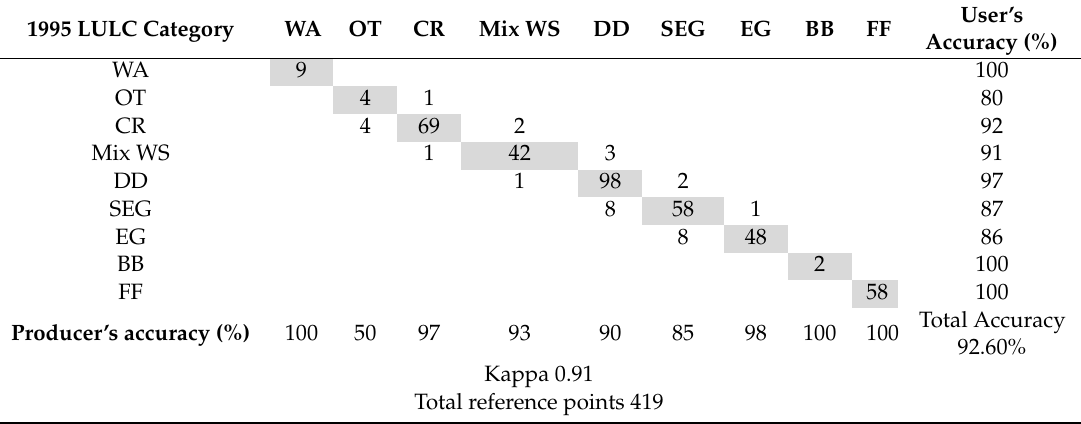
Table A2. Results of the accuracy assessment of the PBTC land cover map for